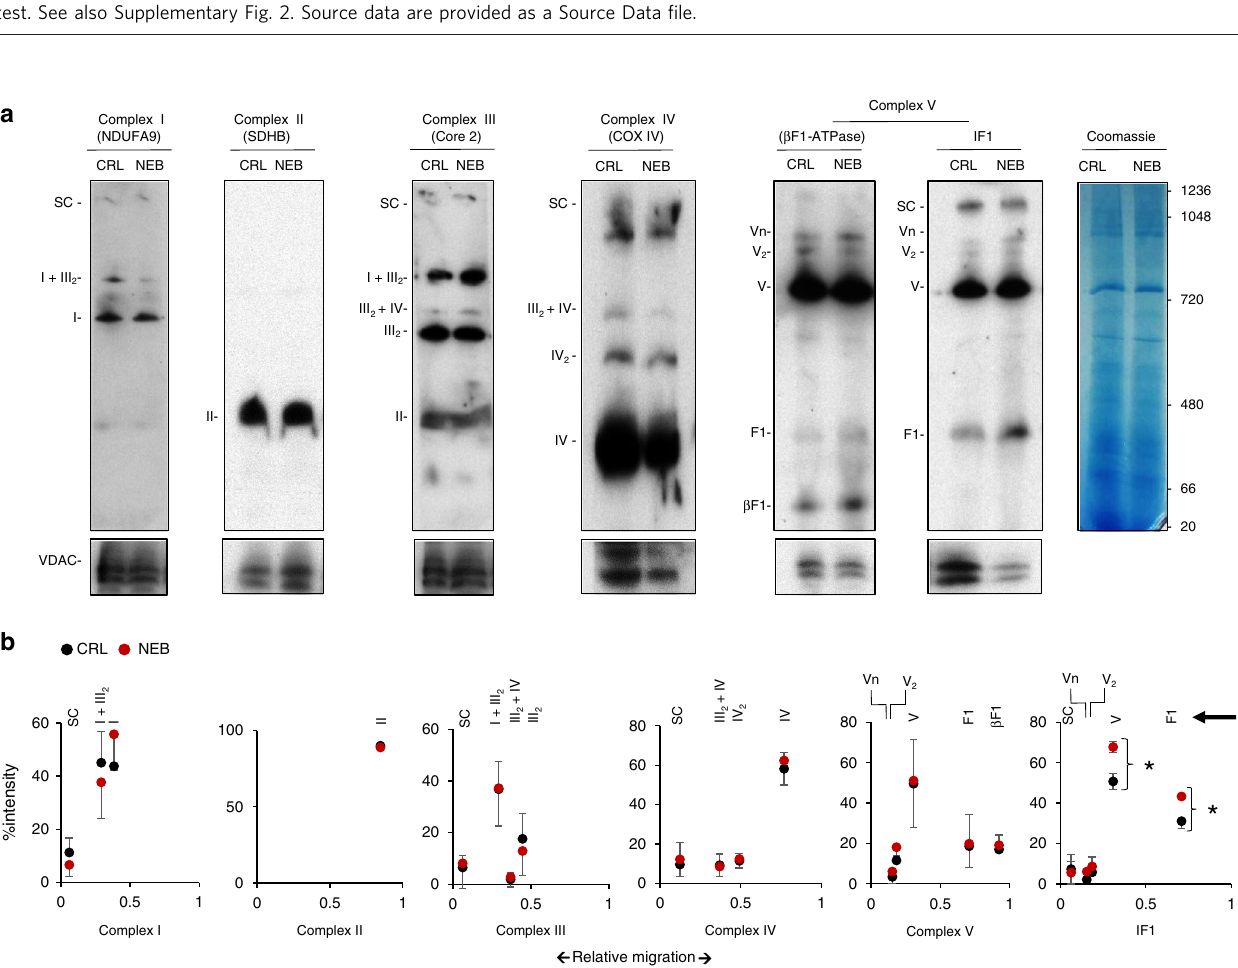
Fig. 3 Nebivolol increases the amount of IF1 bound to the ATP synthase. HCT116 cells were treated (NEB, red) or not (CRL, black) during 3 h with 1 µ M nebivolol. a Representative BN-immunoblots of mitochondrial membrane proteins blotted with the antibodies of the indicated subunits of the different OXPHOS complexes. The migration of supercomplexes (SC); complex I and I + III 2 (NDUFA9); complex II (SDHB); complex III 2 , III 2 + IV and I + III 2 (Core 2); complex IV, IV 2 and III 2 + IV (COX IV); oligomers (Vn), dimers (V 2 ), monomers (V), F1-ATPase and β -F1-ATPase subunit of the ATP synthase and their co-migration with IF1 are indicated. The migration of molecular mass markers is indicated in the Coomassie-stained gel and applied for all blots. VDAC and Coomassie-stained gel are shown as loading controls. b Plots of the quanti fi cation of the relative migration (arrowhead) of fractionated OXPHOS complexes. Bars indicate the mean of three different experiments ±SEM. * p = 0.042 (V) and 0.039 (F1) when compared to CRL by two-sided Student ’ s t test. Source data are provided as a Source Data fi the activity of the other complexes (Fig. 4h, i). Changes in immunocaptured proteins from HCT116 and MDA-MB-231 cells the activity of Complex I correlate with differences in the (Fig. 4j). Phosphoproteomic analysis by MS-spectrometry of the phosphorylation of subunits of the complex 23 . Nebivolol also peptides derived from the 15 – 20 kDa region of the gels (see red signi fi cantly diminished the phosphorylation of SC (Fig. 4a), box in Fig. 4j) indicated that S117 contained in a tryptic peptide derived from NDUFS7 subunit was the only peptide from com- volol speci fi cally inhibited the phosphorylation of complex I plex I that was not phosphorylated when the cells were treated